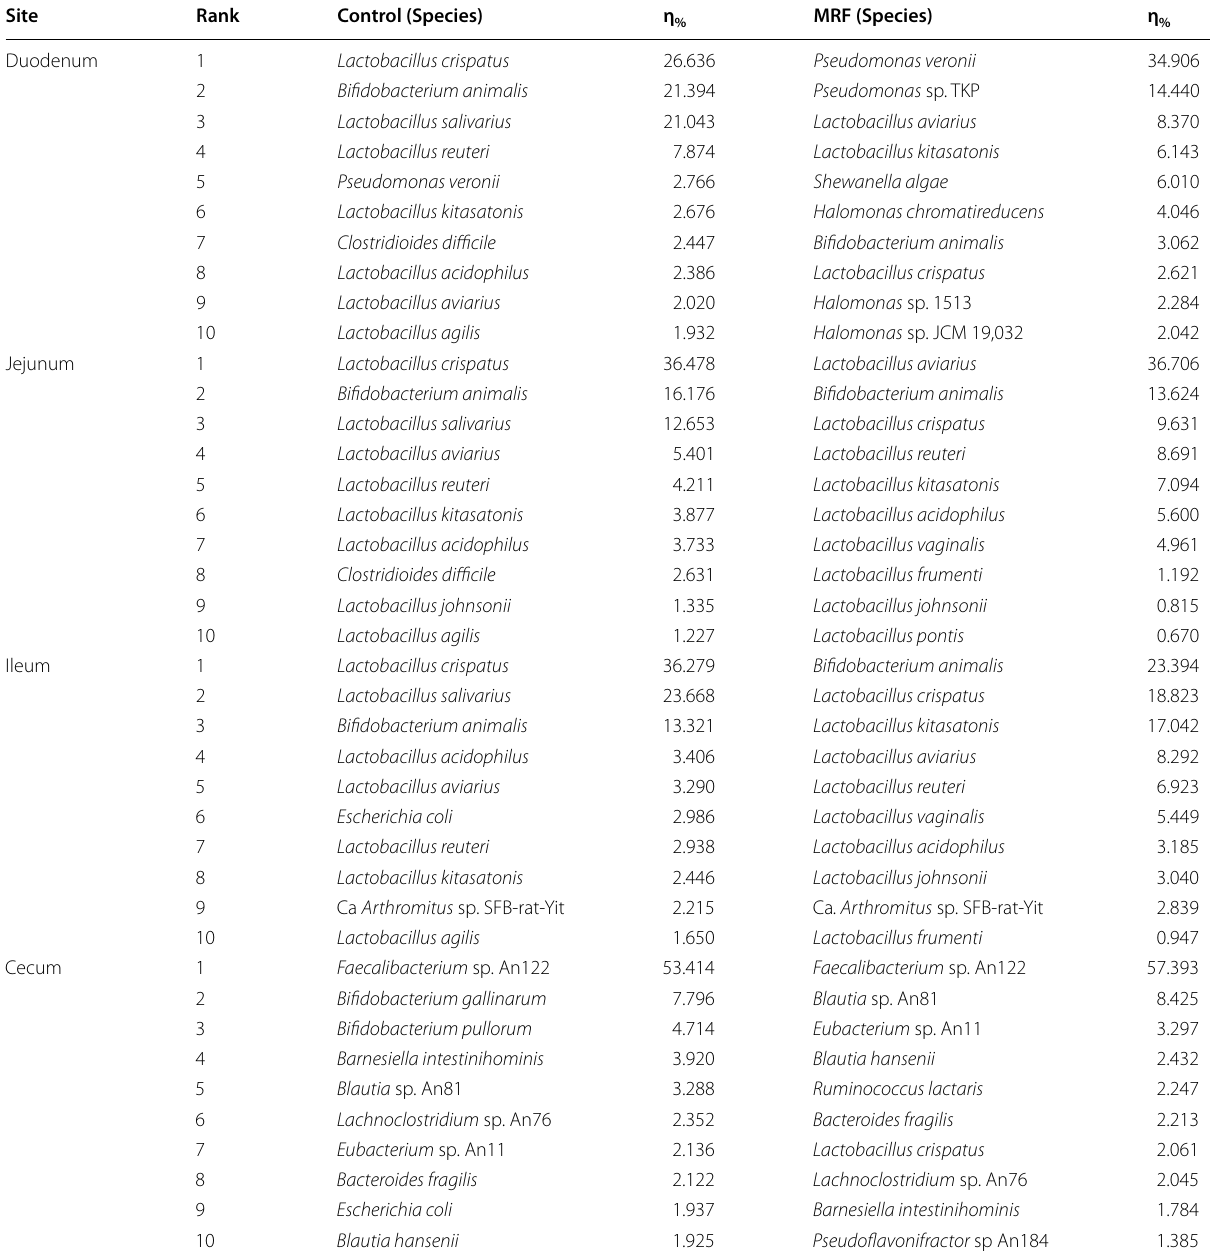
Table 4 The (ten) most prevalent bacterial species observed at each anatomical site in both control and MRF-treated